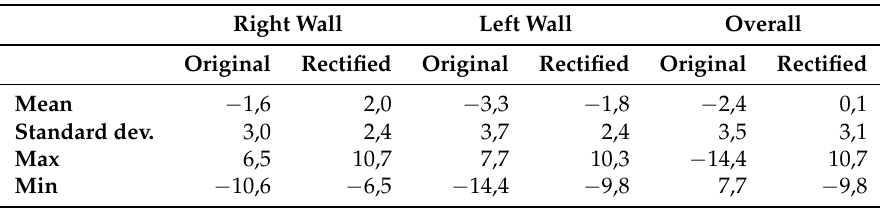
Table 2. Analysis of the distributions of distances between the laser mesh and the sonar point cloud before and after tilt correction of the MSS. By convention, the distances are positive when the sonar points are inside the lock in the laser model (i.e., the points from the MSS are closer to the center of the lock than their counterparts from the TLS). Distances are given in centimeters. Right Wall Left Wall Overall Original Rectified Original Rectified